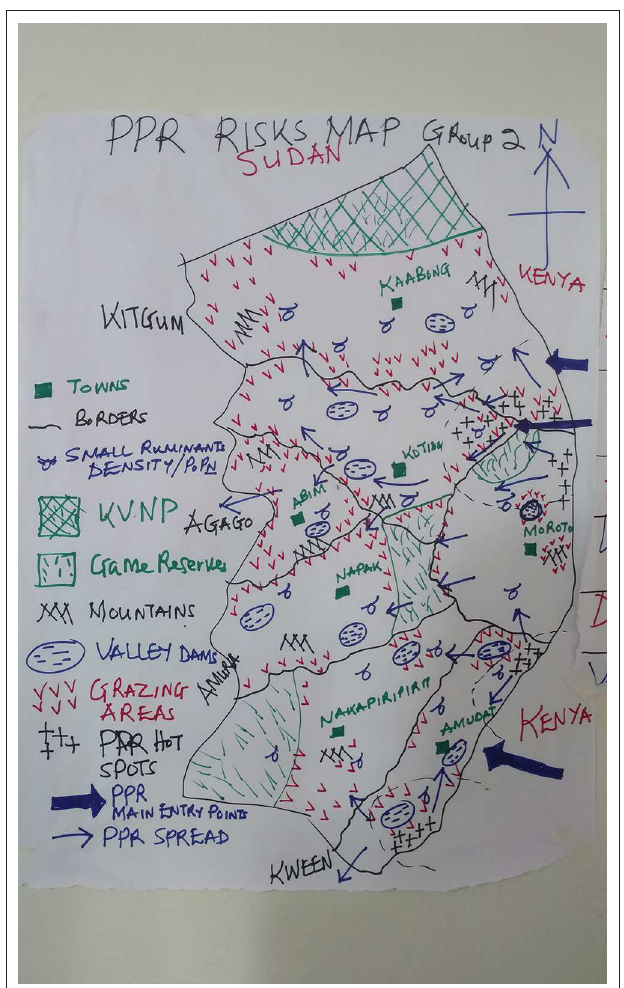
FIGURE 2 | Example of a Karamoja Risk Map. Example of a risk map drawn by a focus group of veterinarians, community animal health workers and kraal leaders from across Karamoja. The thick blue arrows indicate the perceived main entry points for PPR to Karamoja and the thin blue arrows represent spread across Karamoja. Black crosses are PPR transmission hotspots. The northern focus includes Nakapelimoru subcounty of Kotido, Loyoro subcounty of Kaabong District. The southern focus is centered on Loroo sub county of Amudat. A third focus is indicated in the extreme south in Karita sub county of Amudat was not included in the project for financial